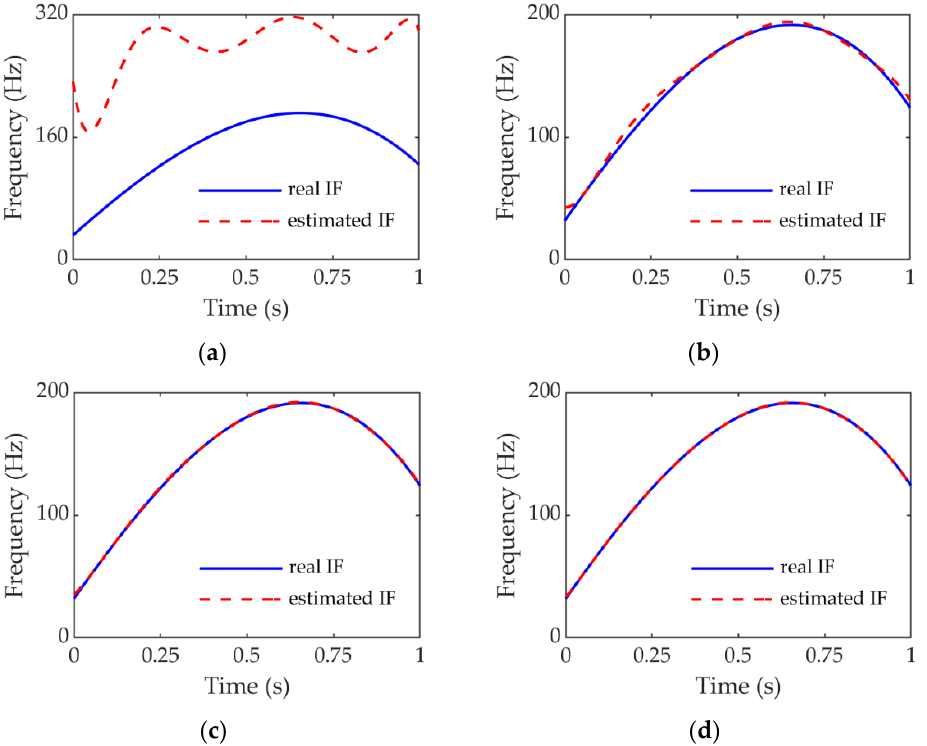
Figure 2. The real IF compared with the IF estimated by N th iteration for the noisy signal (SNR = 0dB): ( a ) the first iteration with MAPE = 112.56%; ( b ) the second iteration with MAPE = 2.44%; ( c ) the third iteration with MAPE = 0.45%; and ( d ) the fifth iteration with MAPE = 0.18%.